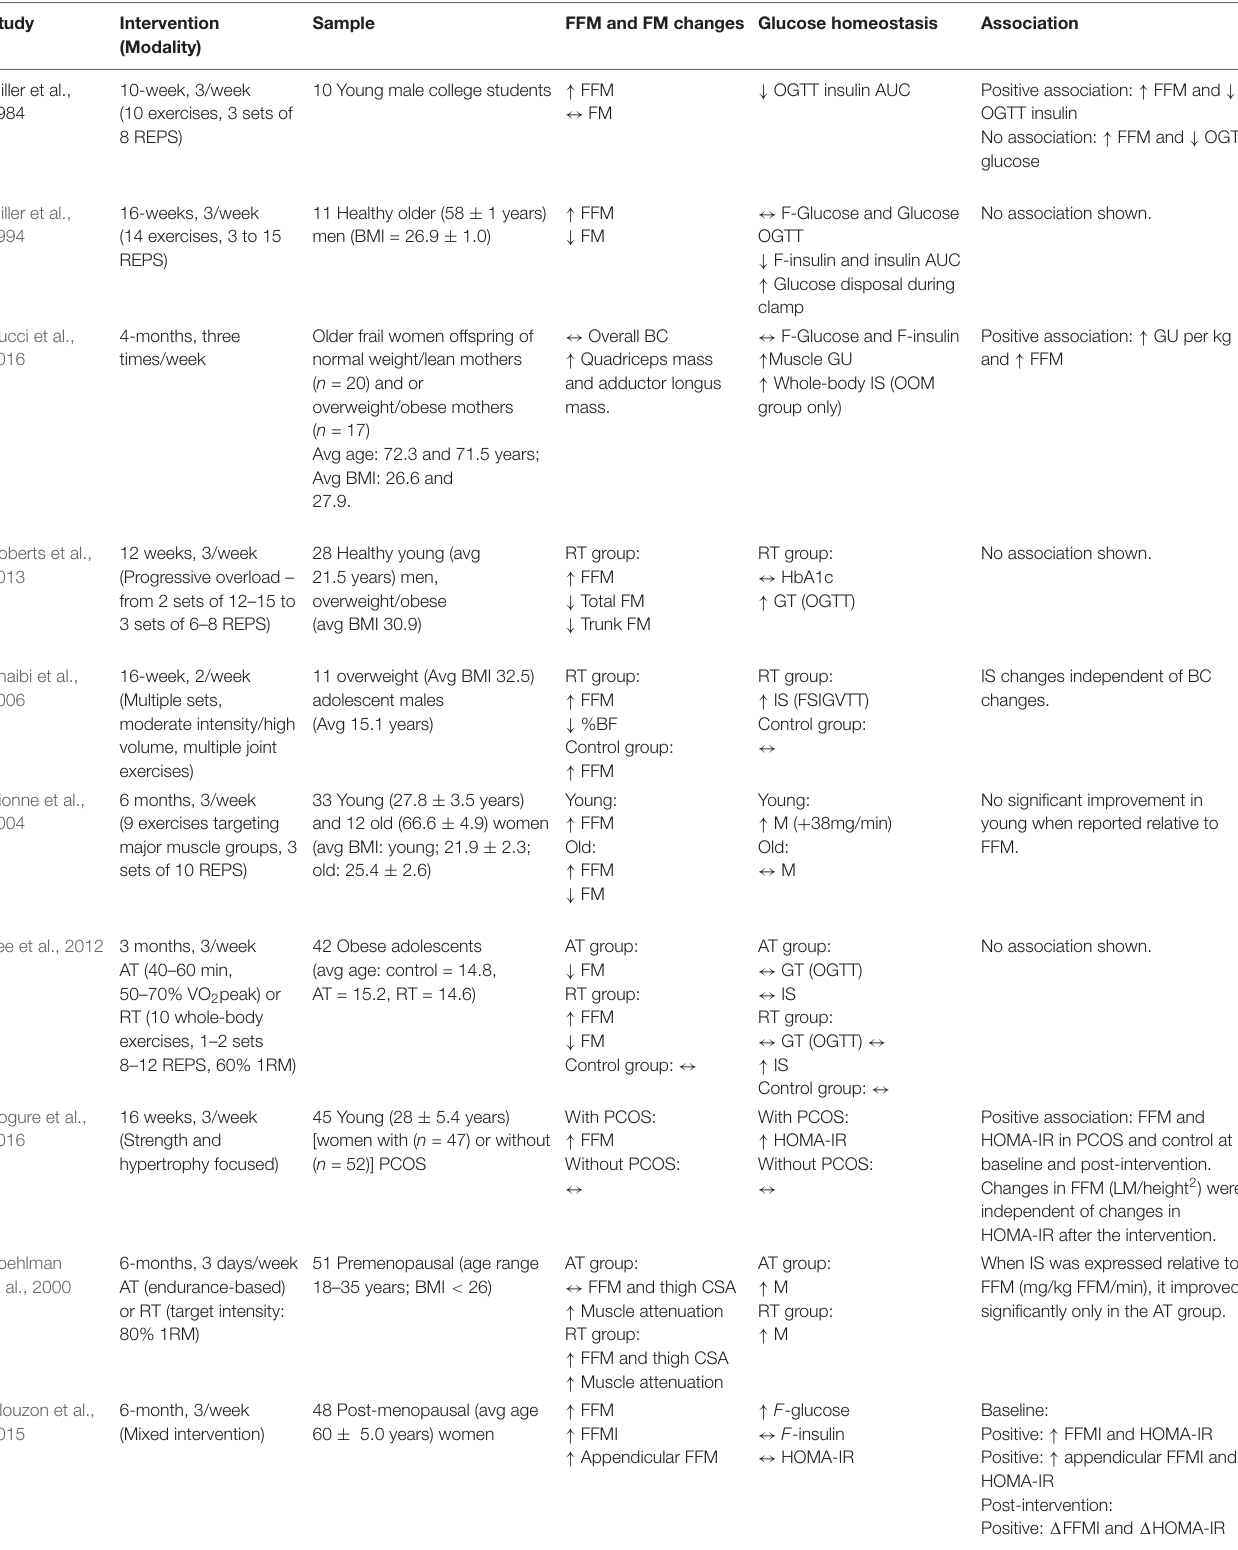
TABLE 1 | Summary of studies that has investigated fat-free mass quantitative changes and glucose homeostasis in response to either resistance or mixed training intervention or a comparison.